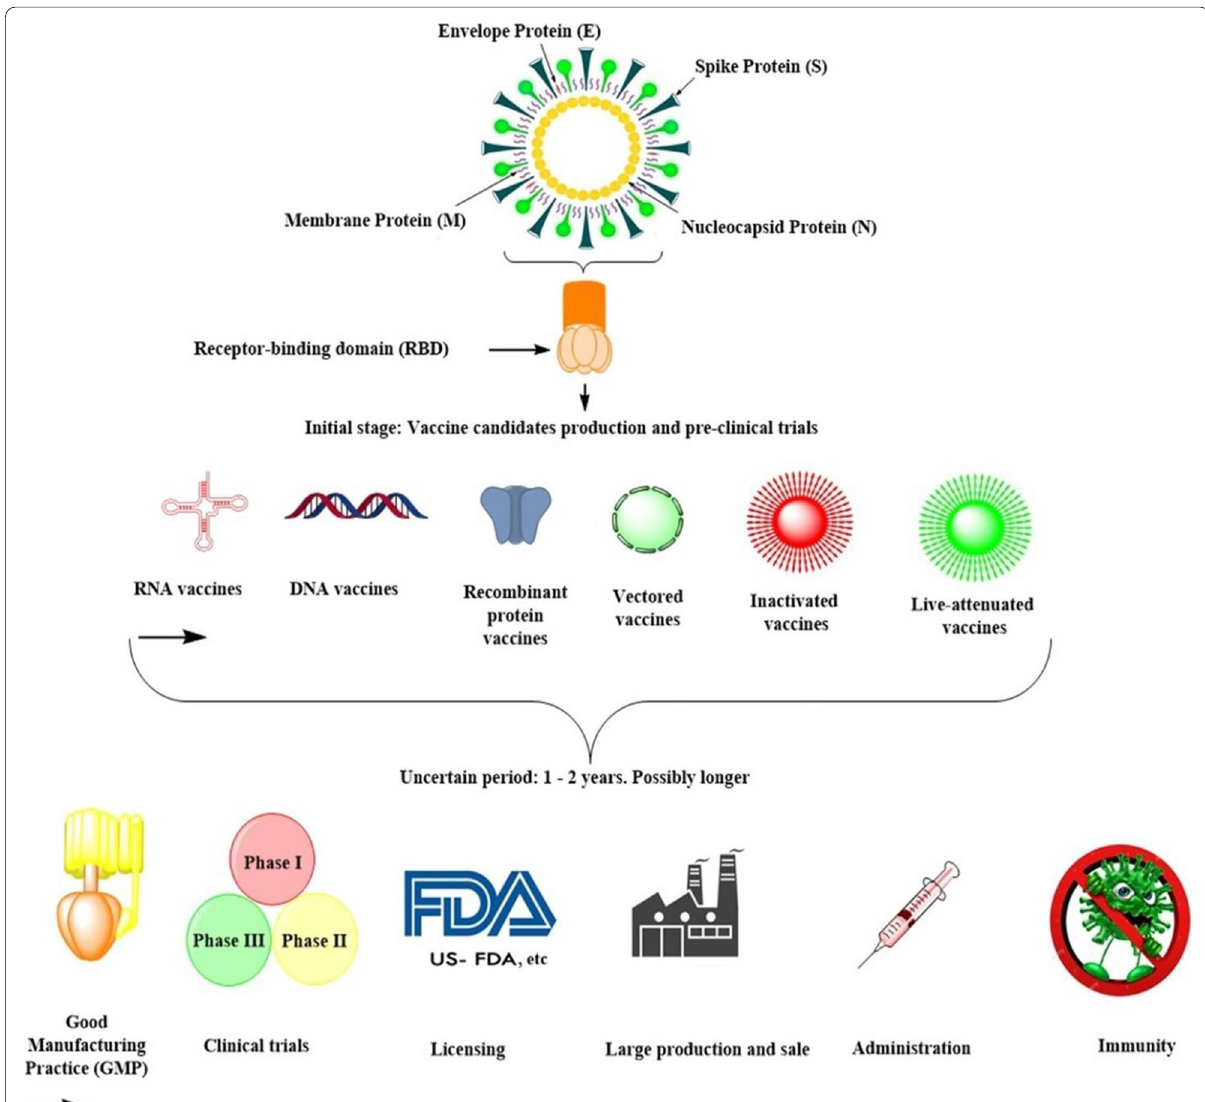
Fig. 2 Schematic representation of the different types of vaccine technologies available